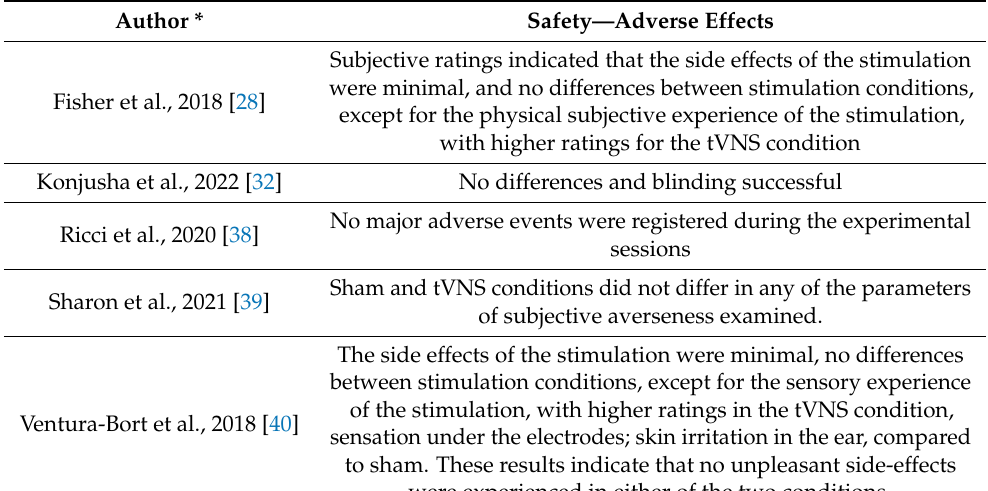
Table 3. Reported adverse events of